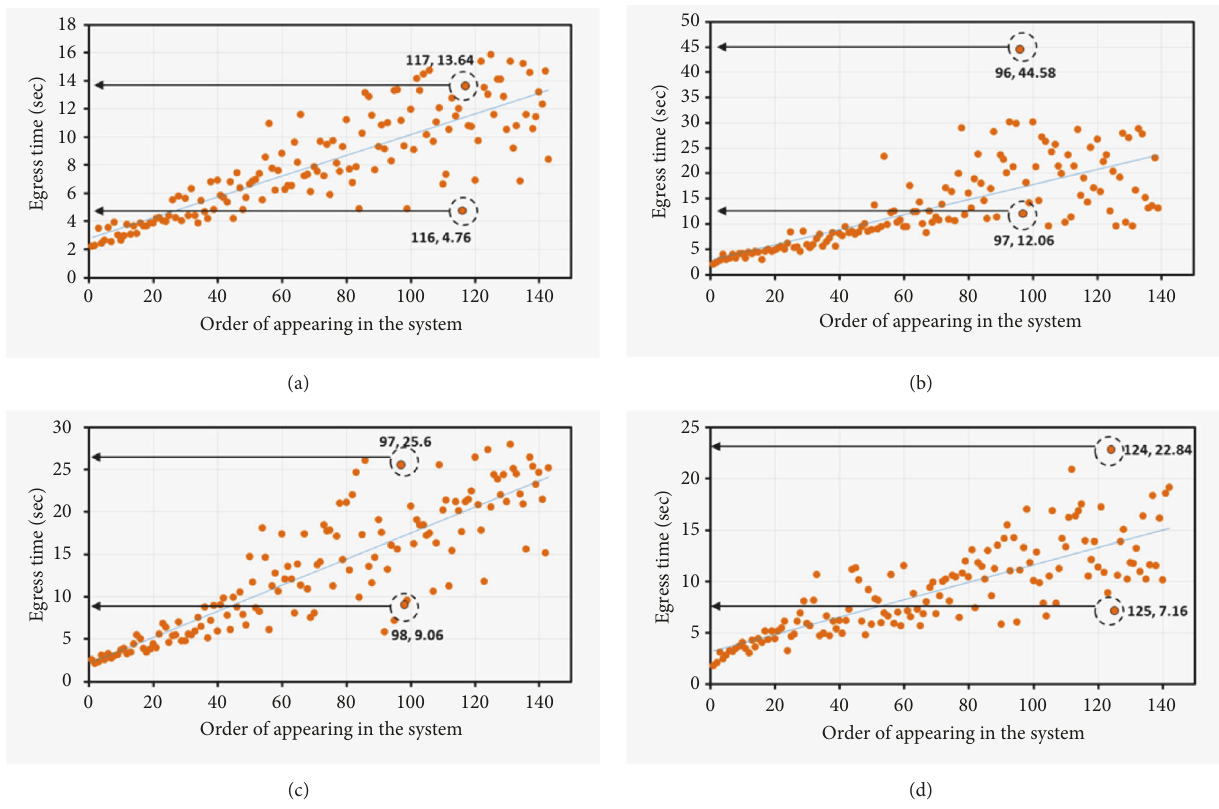
Figure 2: Scatterplots of the individual evacuation times for a sample of four experimental scenarios. Each plot orders the individuals based on the time of their appearance (entrance) in the system. On each plot, a pair of points have been singled out. Each of these pairs of points represents two individuals who entered the environment consecutively (at nearly the same time), but their decisions had majorly different outcomes in terms of the evacuation